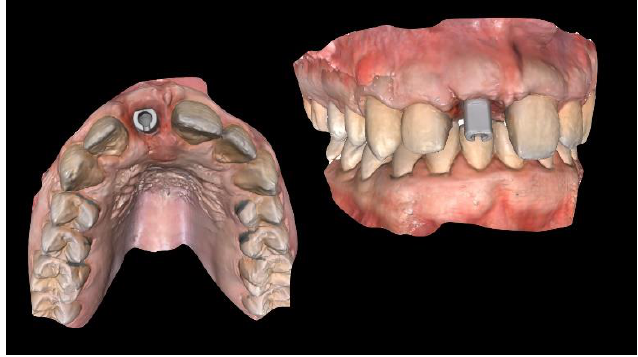
Figure 11. Intraoral digital impressions.